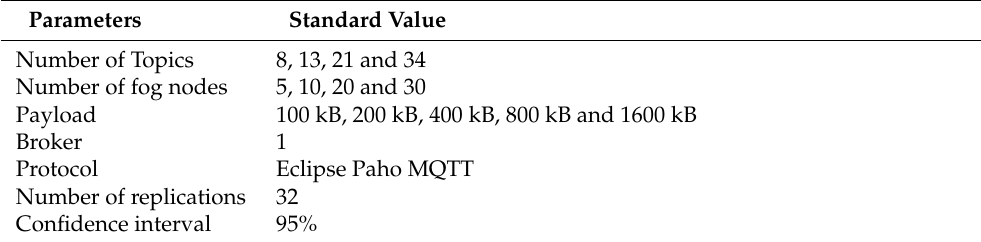
Table 2. Set of parameters employed to generate the